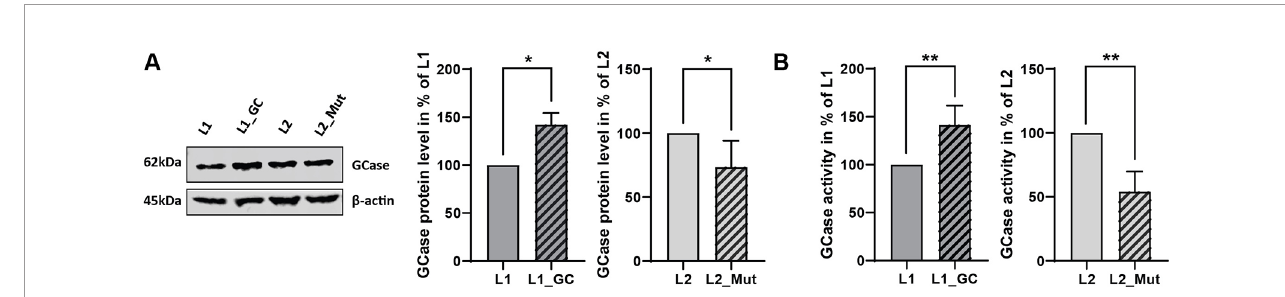
FIGURE 3 | Functional validation of gene-editing of GBA . (A) Representative immunoblot and densitometry quanti fi cation of GCase protein levels in iPSCs expressed in % of non-edited line (mean ± SD, n = 5, two-tailed paired t-test *p < 0.05). (B) GCase activity in iPSCs expressed in % of non-edited line (mean ± SEM, n = 5, two-tailed paired t-test **p <